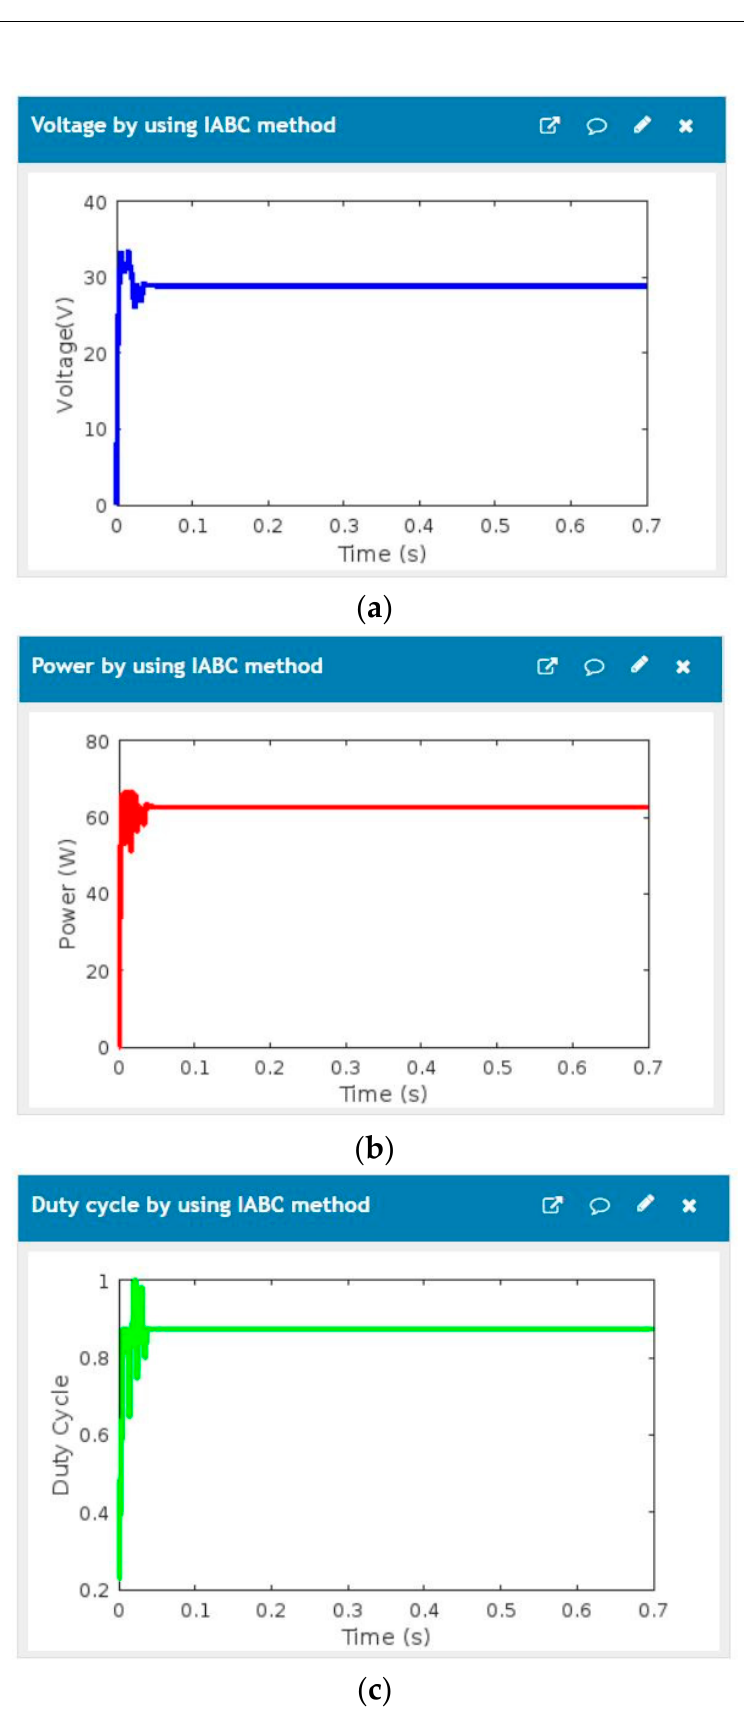
Figure 18. SCADA graphical user interface; ( a ) the voltage, ( b ) the power, and ( c ) the duty cycle using the IABC method.